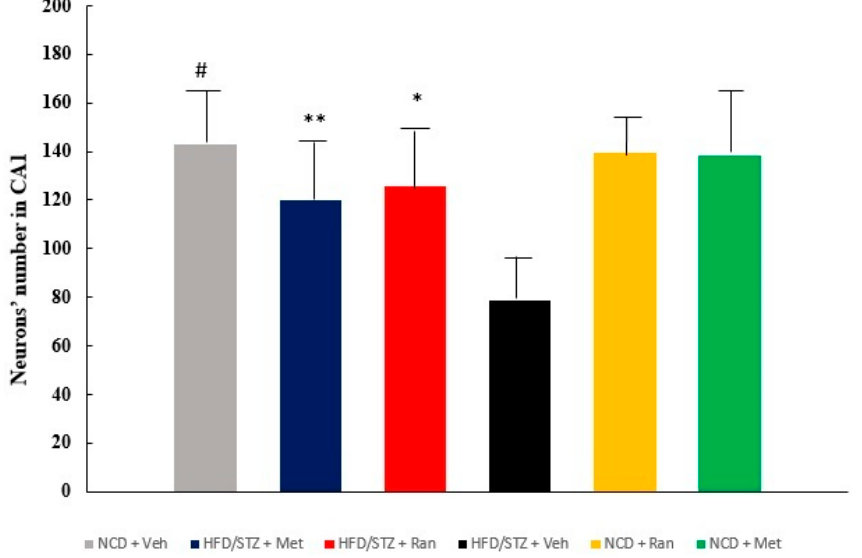
Figure 2. Neuronal count in the hippocampal CA1 region of the six study groups. Values are the mean ± SD ( n = 6 per group). * p = 0.0011 HFD/STZ + Vehicle vs. HFD/STZ + Ranolazine, ** p = 0.039 HFD/STZ + Vehicle vs. HFD/STZ + Metformin, # p < 0.0001 HFD/STZ + Vehicle vs. NCD + Vehicle (Sidak’s test). HFD = high fat diet; NCD = normocaloric diet; STZ = streptozotocin.